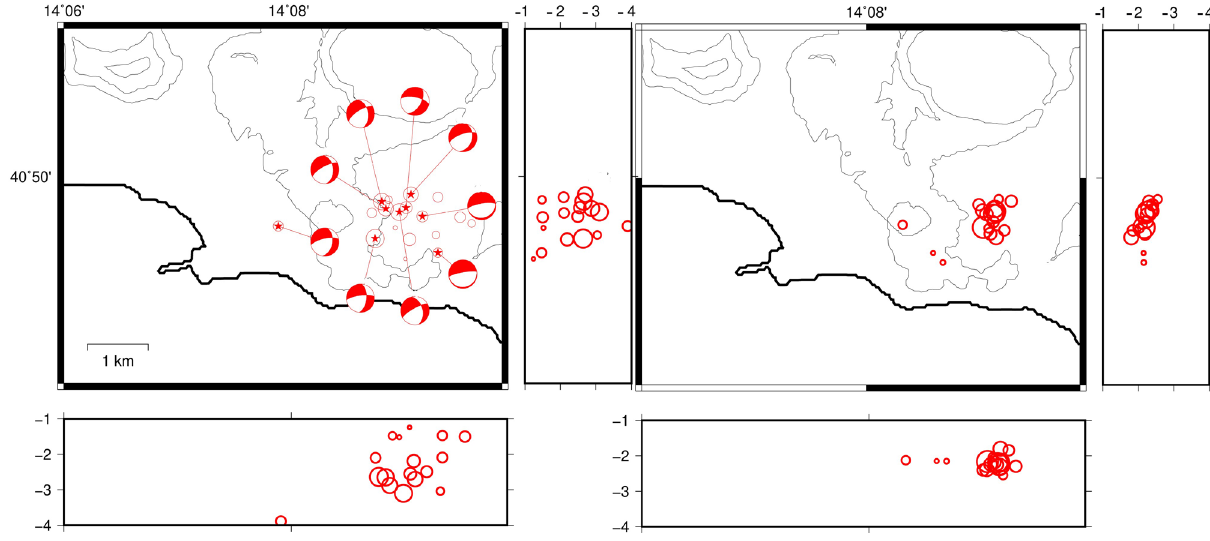
Figure 4. Location of the earthquakes of the swarm of 7/10/2015 using NLLoc (sx) and HypoDD (dx). Circle sizes are proportional to the earthquake magnitude. The images were obtained using the free software GMT